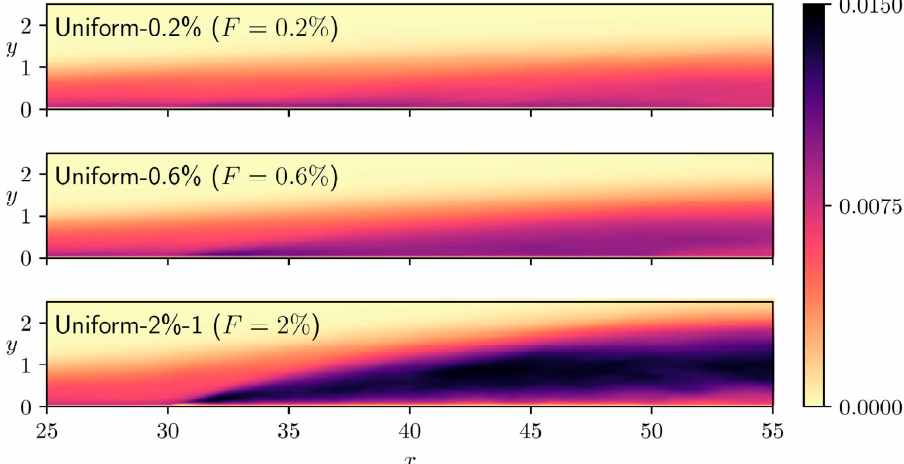
Figure 30. Average turbulent kinetic energy at different injection ratios. Reprinted with permission from [122]. Copyright 2020 Elsevier.